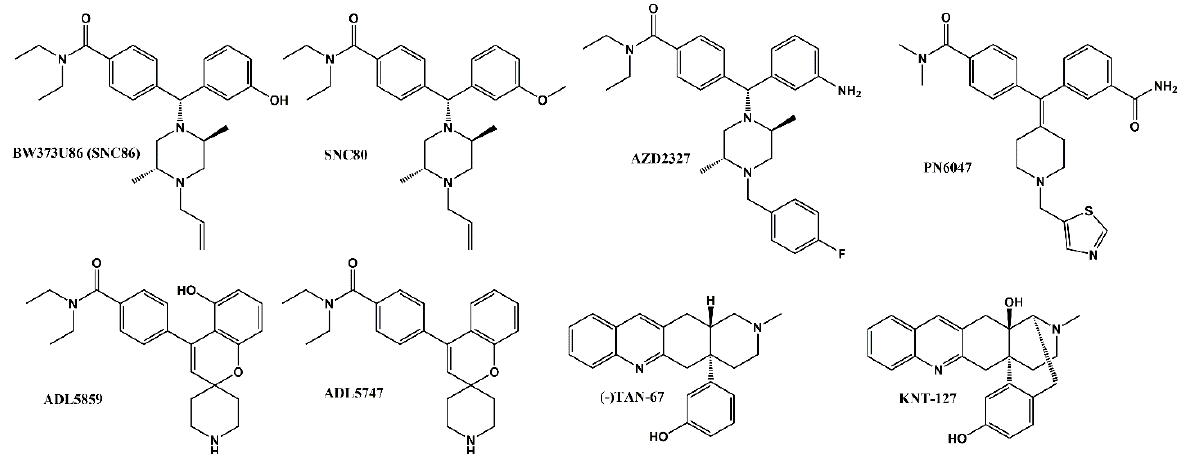
Figure 1. Chemical structure of δ OR agonists. BW373U86 (SNC86), SNC80, AZD2327, PN6047, ADL5859, ADL5747, (-)TAN-67 and KNT-127.